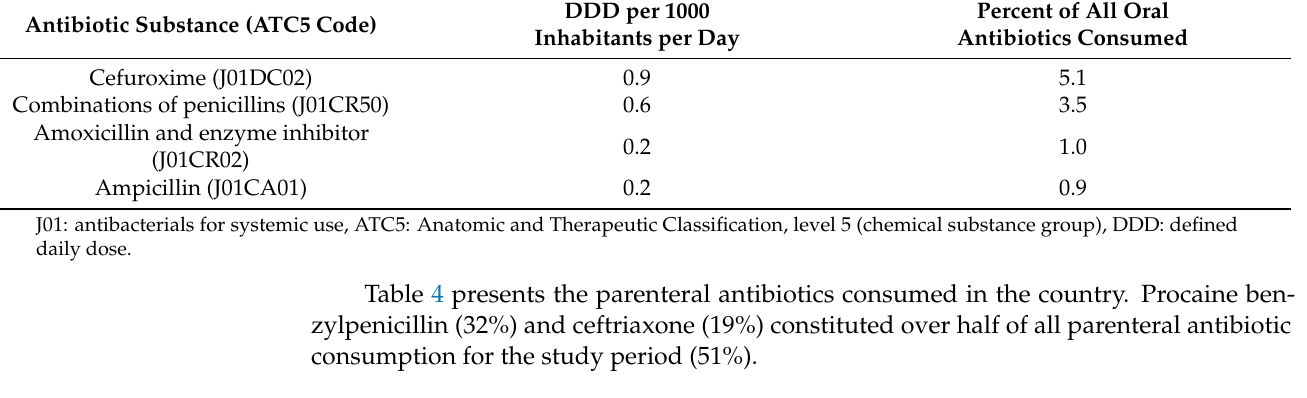
Table 4. Top ten most commonly used parenteral antibiotics (J01, ATC5) by DDD per 1000 inhabitants and their percentage of all parenteral antibiotics consumed in Sierra Leone,